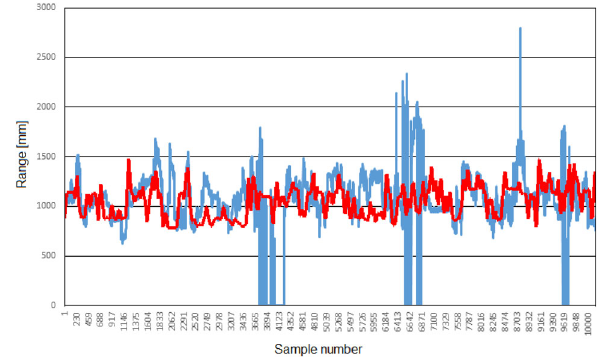
Fig. 15 Radar roof height measurement compared with laser scanner data